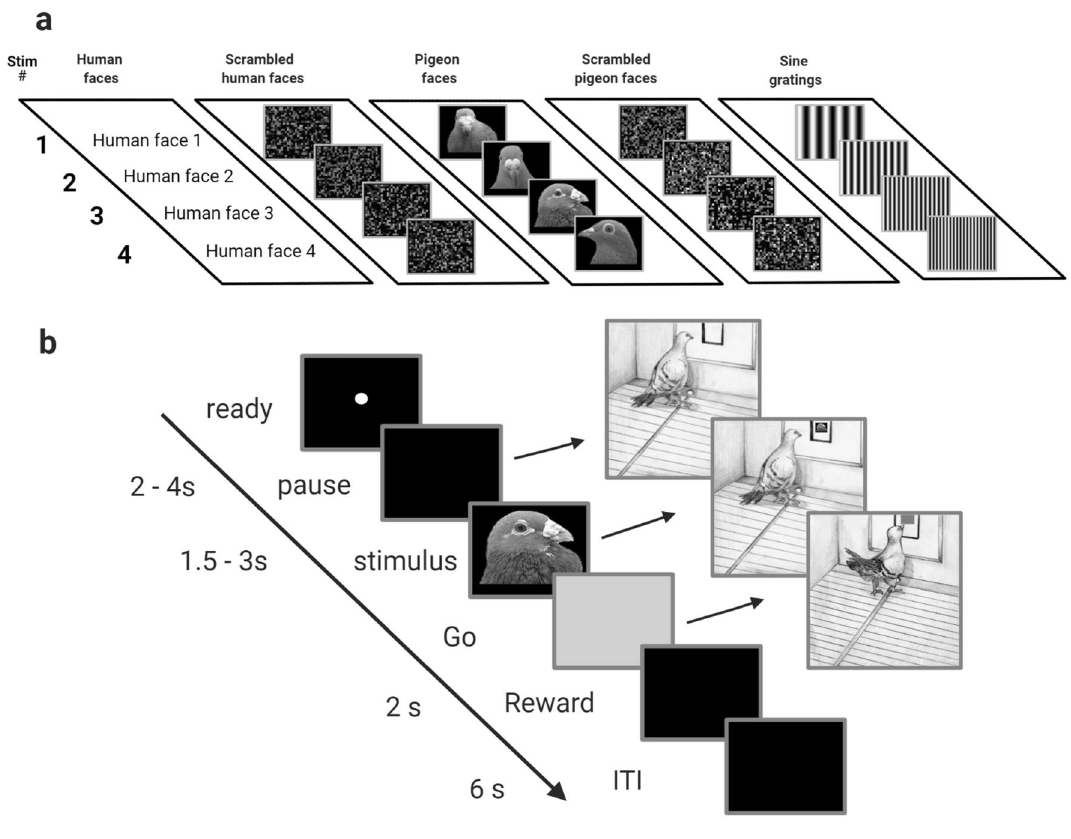
Figure 1. The visual stimuli and behavioural task. ( a ) Images of the five stimulus groupings with the four examples of each grouping used in the experiment. The stimulus groupings consisted of human faces, scrambled human faces, pigeon faces, scrambled pigeon faces, and sine gratings. ( b ) Sequence of events within a single experimental trial. Trials began with an orienting stimulus on screen (white dot) during the ready period. The pigeon pecked the orienting stimulus two times to start a pause period of random duration (2–4 s) with a black screen. Pecks during the pause period extended the duration of the period by 2 s. A stimulus was then displayed for a random duration (1.5–3 s) during the stimulus period. Any pecks during the stimulus period initiated a repeat of the trial from the start of the ITI period. Following the stimulus period, a Go cue (grey square) replaced the stimulus. A peck to the Go cue delivered grain reward from the hopper (2 s) that was paired with a tone (1000 Hz) and illumination of the hopper, followed by a black screen during the 6 s ITI. Pecks during the ITI period extended the duration of the period by 2 s. Scrambled images were created using open access Webmorph software (https:// fei. edu. br/ ~cet/ faced ataba se. html): Lisa DeBruine. Webmorph (Beta Release 2). Zenodo (2018). https:// doi. org/ 10. 5281/ zenodo. 10736 96. Human face images not shown due to copyright Neuronal recording. The microdrives housed eight 25 μm Formvar-coated nichrome wires (California Fine Wire, Grover Beach, CA, USA) used to measure single neuron activity 26 . For each experimental session we searched for activity on any one of the eight wires and used one of the remaining wires as the indifferent. The signals were amplified using a Grass P511K amplifier (Grass Instruments, Quincy, MA, USA) and 50 Hz noise was eliminated using a notch filter. A CED (Cambridge Electronic Design, Cambridge, UK) electrophysiology system with Spike2 software stored and analyzed the data. Cells were isolated using CED’s template matching capacity (thereby eliminating artefacts) sampling at a rate of 20,000 Hz. The selection criterion was that the iso- lated neuron had a signal-to-noise ratio of no less than 2:1. A separate computer controlled the behavioural task and sent codes to the CED system to align key task events. Following each recording session, the electrodes were advanced approximately 40 μm before the pigeon was returned to their home cage. If we did not record from any neural activity the electrodes were moved approximately 20 μm, and the animal was returned to its cage. For the eight birds that were implanted in MVL, it was possible to subsequently record from ENTO due to its position directly ventral to MVL in the pigeon brain 27 . After advancing the electrode through the entire extent of MVL (2000 μm), the electrode was then advanced another 500 μm into ENTO, and subsequent recordings were per- formed through the extent of ENTO (3000 μm). For two birds (X9 and X29) we recorded directly from ENTO to balance the number of recorded neurons across MVL and ENTO. Recording sessions took approximately 1 h to complete. Pigeons completed one session daily for 5 days a week.